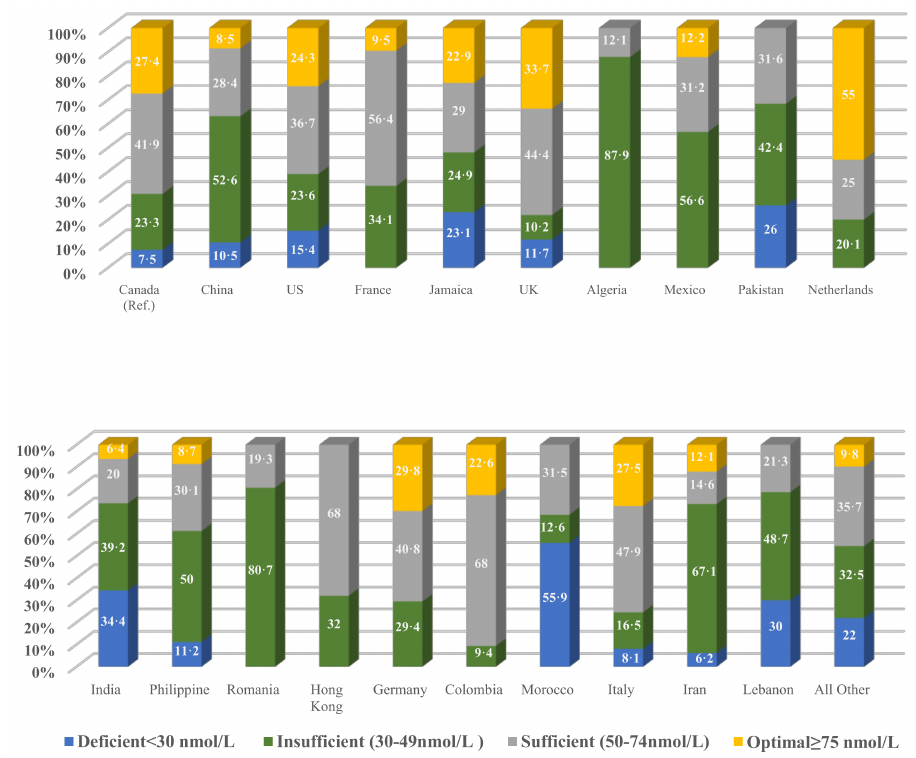
Figure A3. Weighted prevalence of S-25(OH)D status by country of birth using Cycles 3 and 4 of Canadian Health Measures Survey